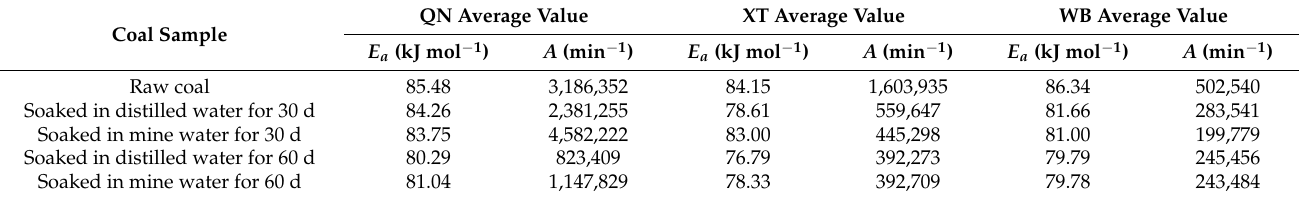
Table 2. Average values of the activation energy and pre-exponential factor of raw coal and water- soaked coal